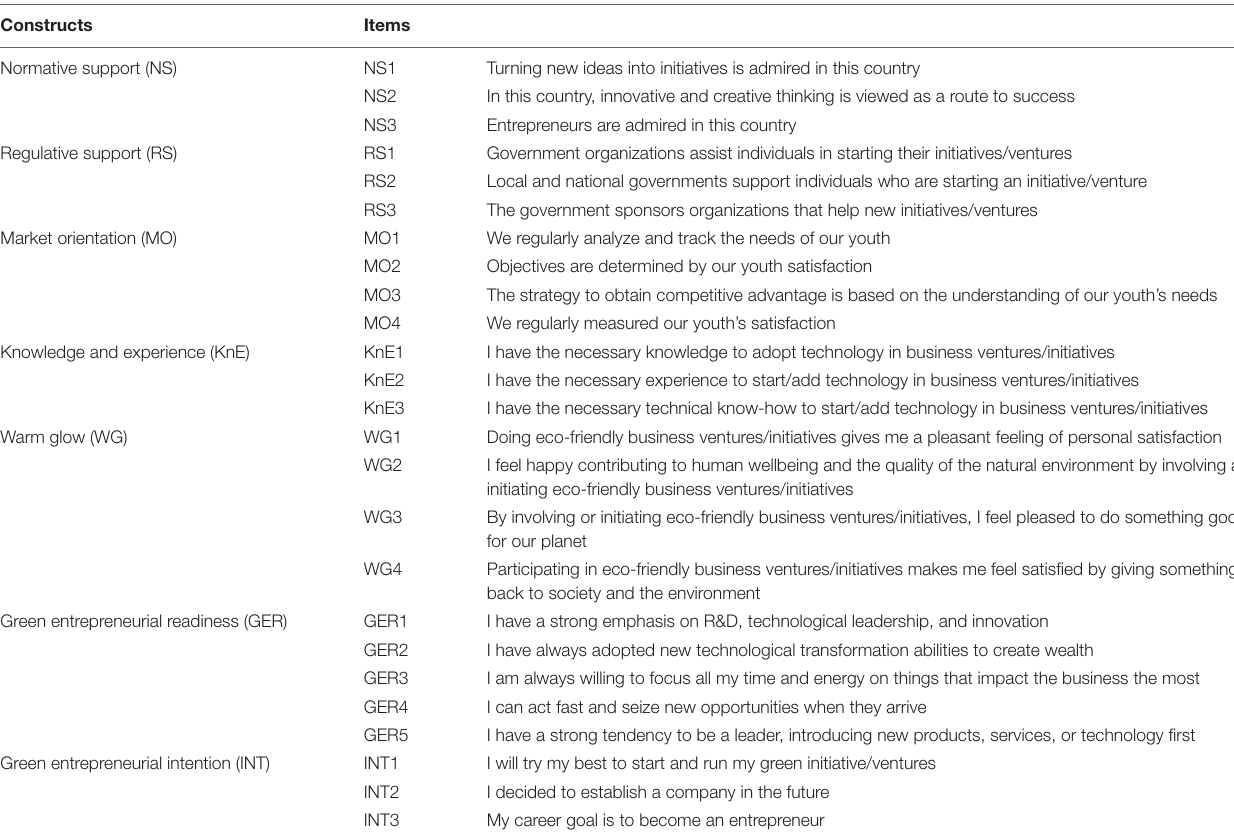
TABLE 1 | Adapted measurement of the constructs. Constructs Items